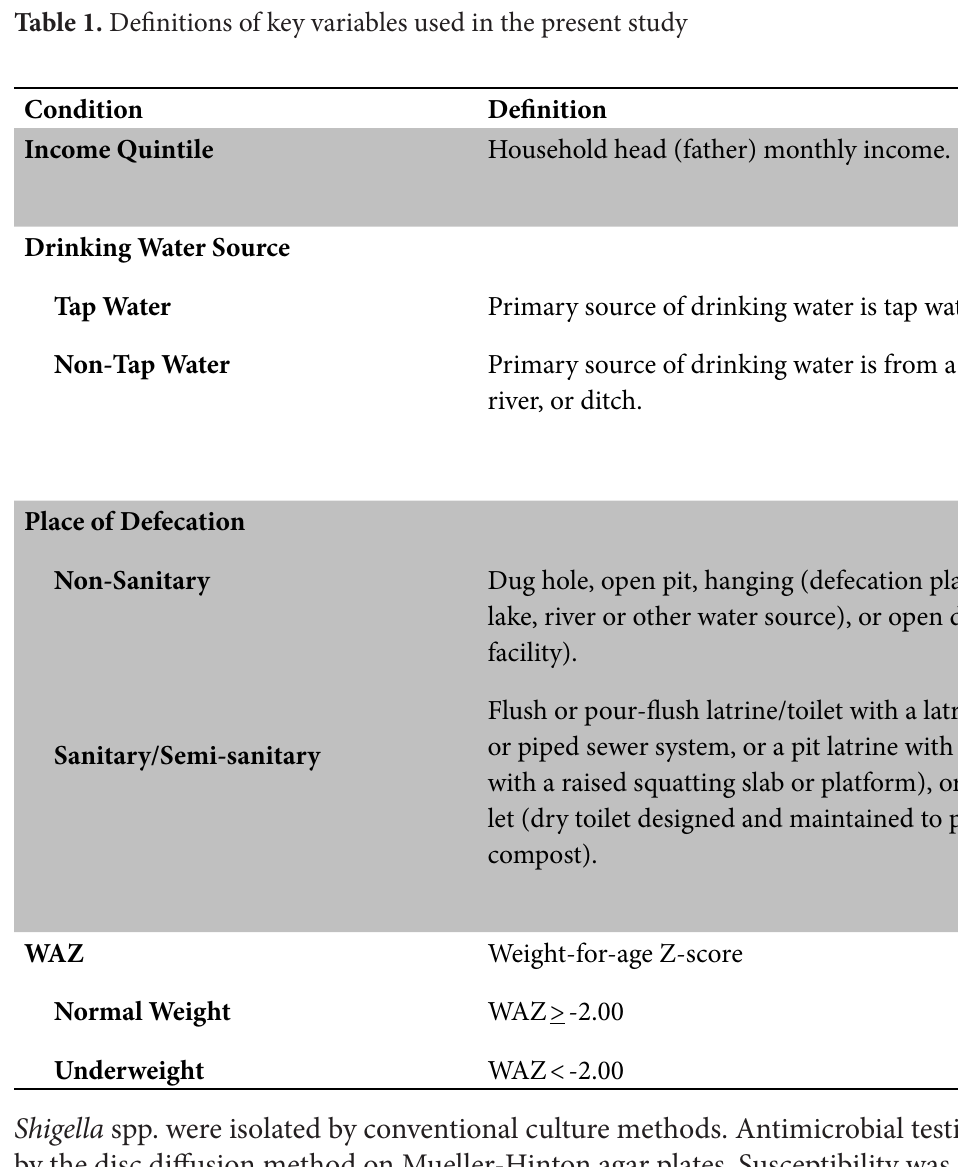
Table 1. Definitions of key variables used in the present